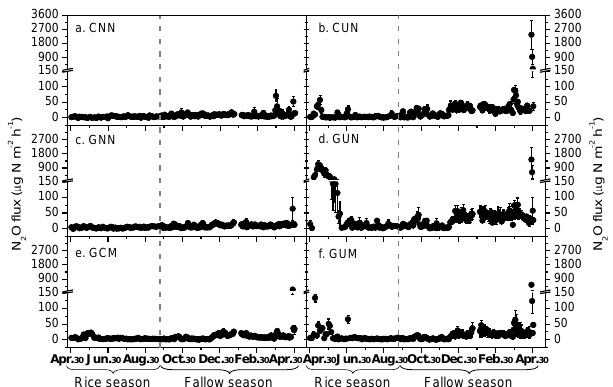
Fig. 5. Figure 5. Seasonal dynamics in (a–f) nitrous oxide (N 2 O) fluxes (mean ± standard error) for different fertilizer treatments in the con- ventional paddy and ground cover rice production systems during the rice–fallow rotation cycle of 2011–2012. The N 2 O fluxes dur- ing the rice season as shown in panels (c–f) were measured from the raised beds of ground cover rice production systems. Definitions of abbreviations for the different fertilizer treatments are shown in the footnotes of Table 1 and in the